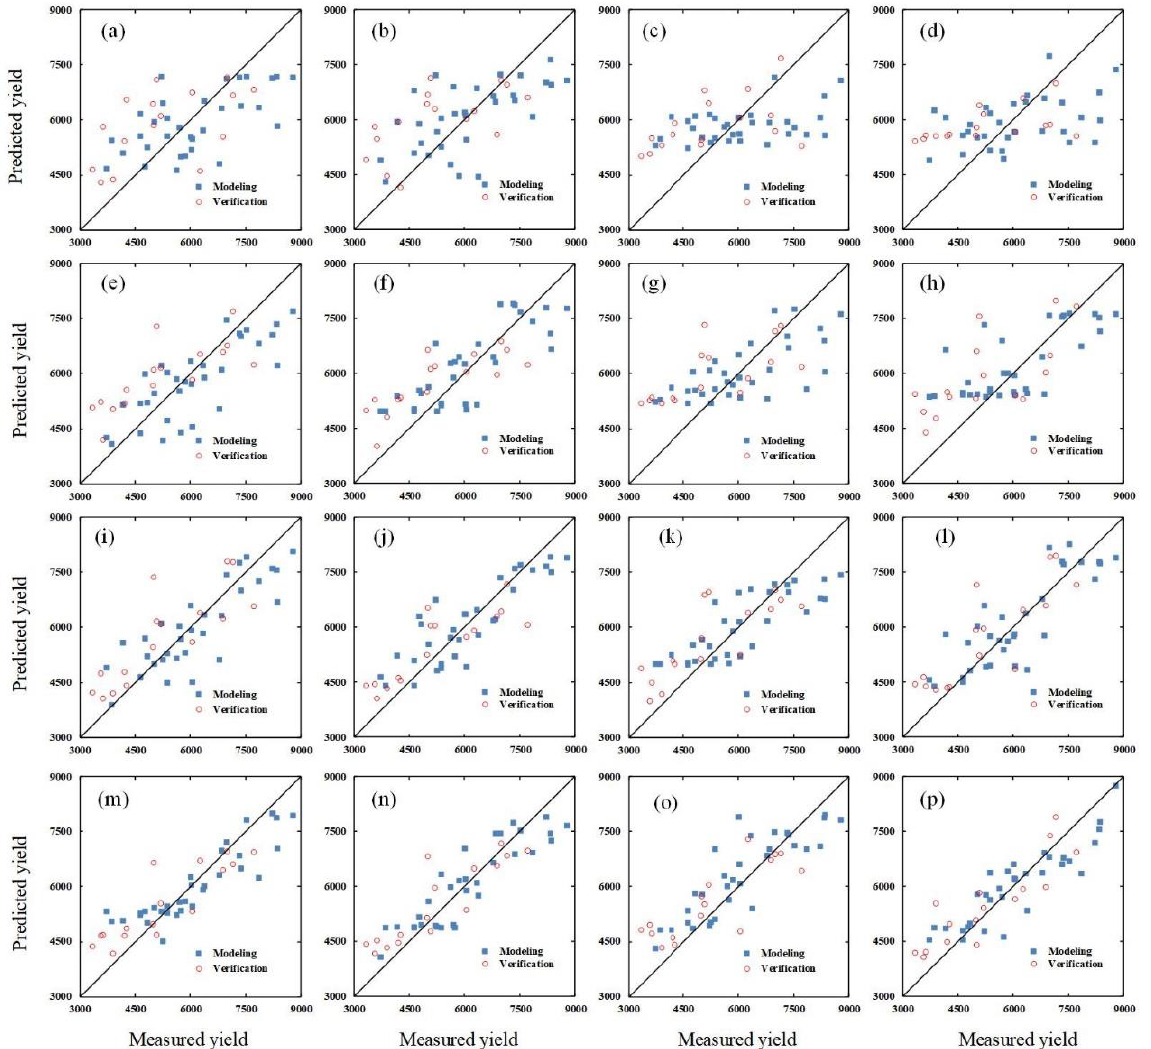
Figure 3. Relationships between the measured winter wheat yield (kg/ha) and the yield predicted using artificial neural network (ANN) regression based on ( a ) ASD-VIs at the jointing stage; ( b ) a combination of ASD-VIs and ASD-REP at the jointing stage; ( c ) UHD185-VIs at the jointing stage; ( d ) a combination of UHD185-VIs and UHD185-REP at the jointing stage; ( e ) ASD-VIs at the flagging stage; ( f ) a combination of ASD-VIs and ASD-REP at the flagging stage; ( g ) UHD185-VIs at the flagging stage; ( h ) a combination of UHD185-VIs and UHD185-REP at the flagging stage; ( i ) ASD-VIs at the flowering stage; ( j ) a combination of ASD-VIs and ASD-REP at the flowering stage; ( k ) UHD185-VIs at the flowering stage; ( l ) a combination of UHD185-VIs and UHD185-REP at the flowering stage; ( m ) ASD-VIs at the filling stage; ( n ) a combination of ASD-VIs and ASD-REP at the filling stage; ( o ) UHD185-VIs at the filling stage; ( p ) a combination of UHD185-VIs and UHD185-REP at the filling stage.